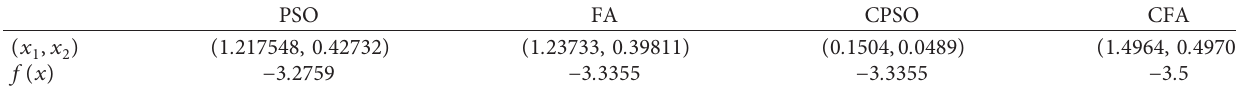
Table 3: The results of problem (2) by using SAs.